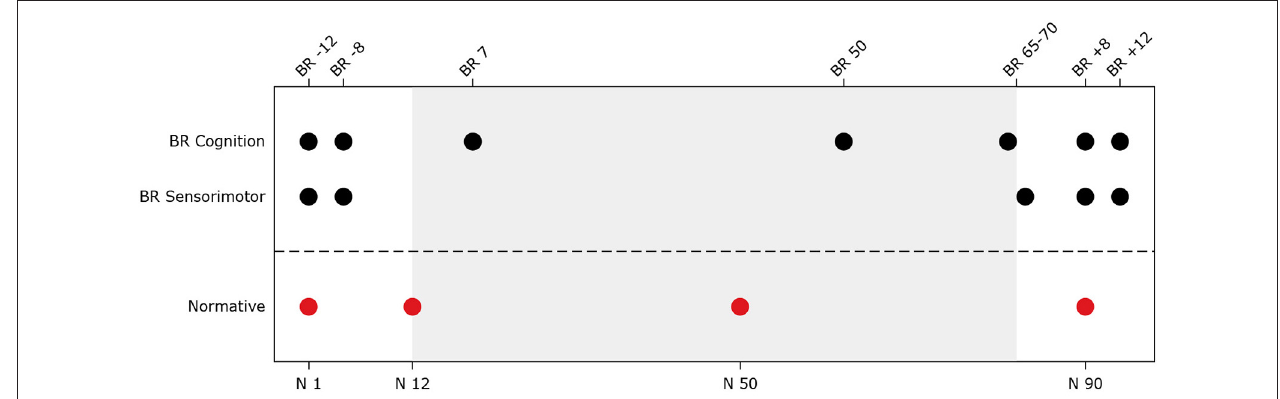
cube rotation test, and card rotation test) took place for the bed rest subjects; BR Sensorimotor = Time points at which sensorimotor tests (i.e., functional mobility test, and sensory organization test (SOT-5 and SOT-5M)) took place for the bed rest subjects; Normative = Time points during which normative subjects completed cognitive tests in supine and seated position and sensorimotor tests.